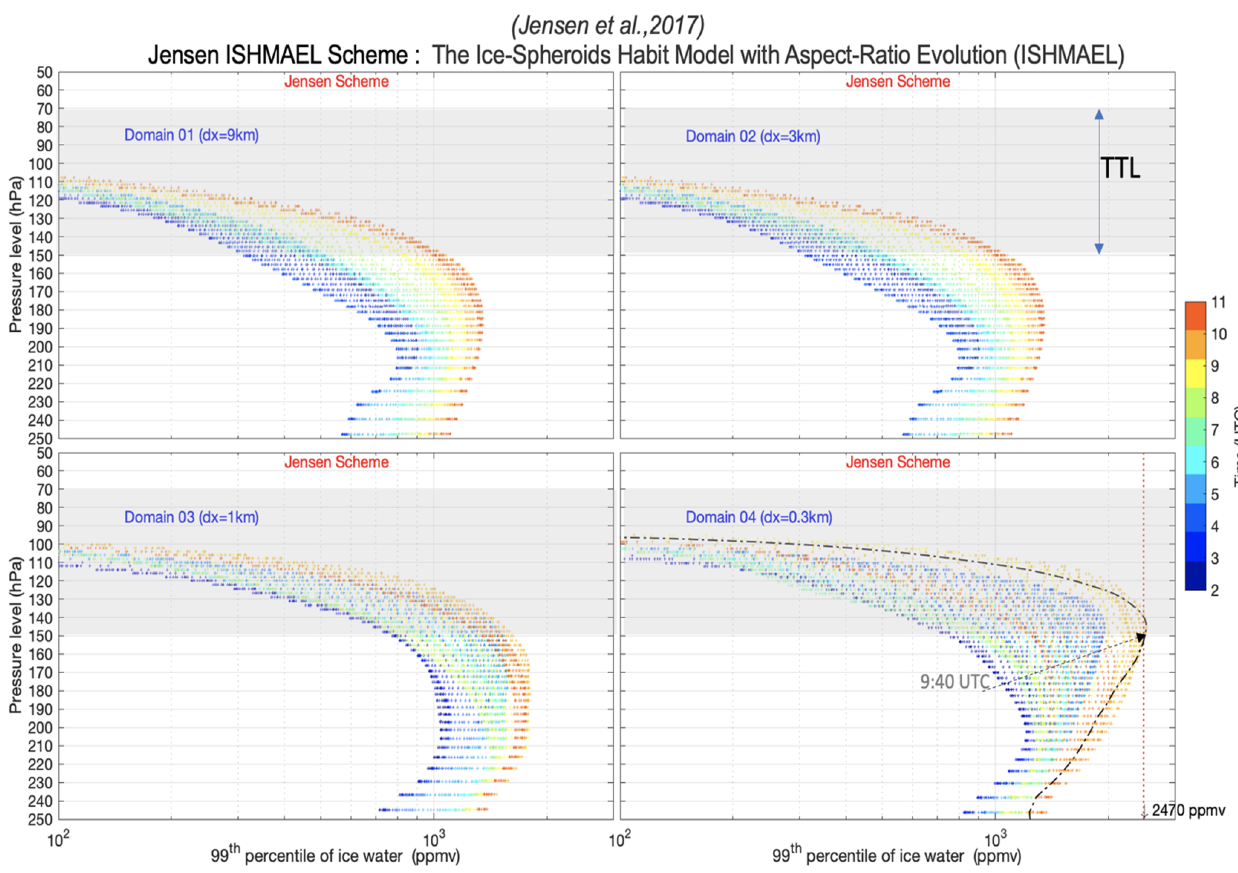
Figure A3. Profile of 99th percentile of simulated IWC below and within the TTL (gray shade) using the ISHMAEL microphysics scheme, with a grid spacing of 9km (upper left), 3km (upper right), 1km (lower left), and 0.3km (lower right) color coded by time (UTC) from 02:00 to 11:00UTC. The dashed–dotted black line (lower right) represents the simulated profile at 09:40UTC (timing of the first captured peak of IWC by aircraft), and the vertical dotted red line represents the observed